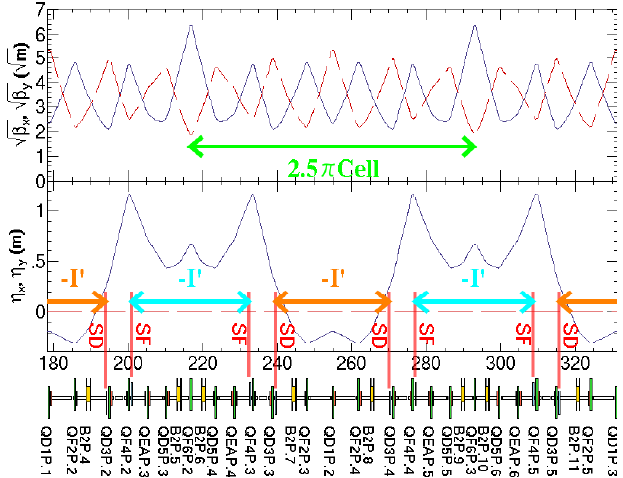
FIG. 1. (Color) Two periods of the 2 : 5 (cid:1) arc cell of LER with beta and dispersion functions. In one arc cell, two (cid:2) I 0 sections are indicated by cyan and orange arrows. In this plot, the blue solid line and the red dashed line correspond to the horizontal and vertical optics functions,